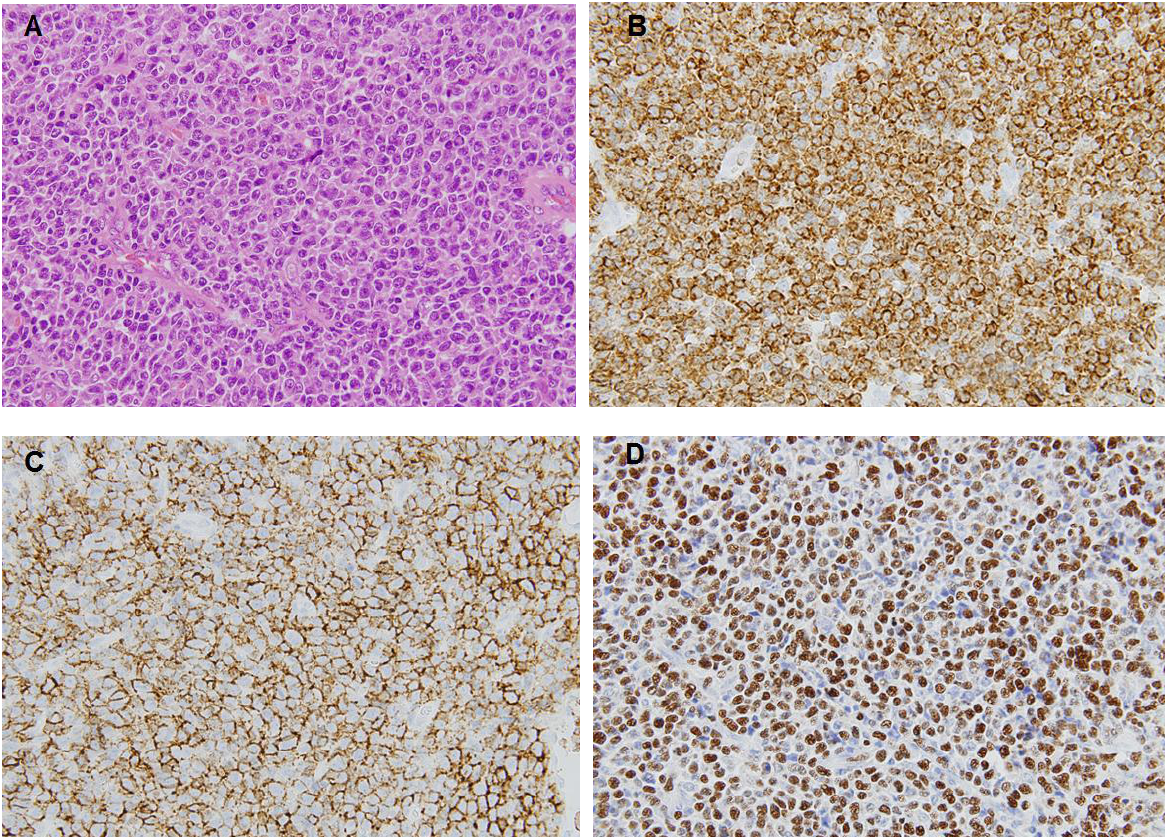
FIGURE 1. Large cells with irregular nuclear contour show a diffuse proliferation (A). These cells are positive for CD3 (B) and CD56 (C), and contain the Epstein-Barr virus genome (D). (A) Hematoxylin and eosin, (B,C) immunohistochemistry, (D) in situ hybridization with EBER probe. All 